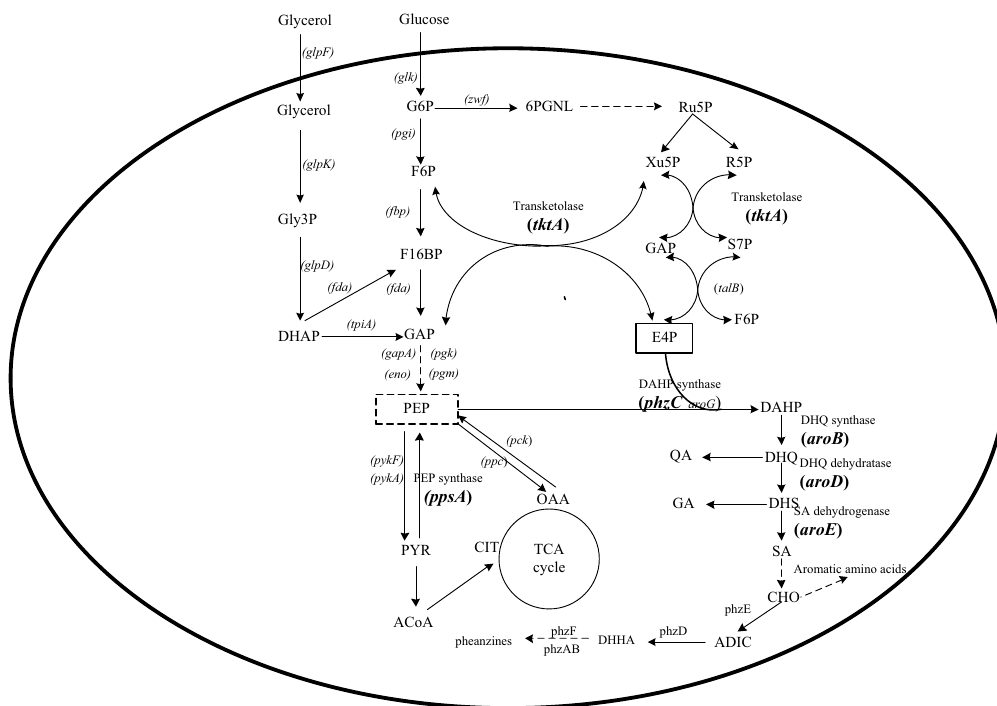
Figure 1. Central carbon metabolism related to the biosynthesis of phenazines in P. chroloraphis Lzh-T5. The enzymes: pgi , phosphoglucose isomerase; glk , glucokinase; eno , enolase; gapA , glyceraldehyde 3-phosphate dehydrogenase; glpK , glycerol kinase; glpF , glycerol facilitator; fda , fructose-1,6-P2 aldolase; glpD , glycerol- 3-P dehydrogenase; fbp , fructose 1,6-bisphosphatase; tpiA , triosephosphate isomerase; talB , transaldolase; zwf , G6P dehydrogenase; pck , PEP carboxykinase; ppc , PEP carboxylase; pgm , phosphoglyceromutase; pgk , phosphoglycerate kinase; phzF, asparagine synthase. DHAP dihydroxyacetone phosphate; Gly3P